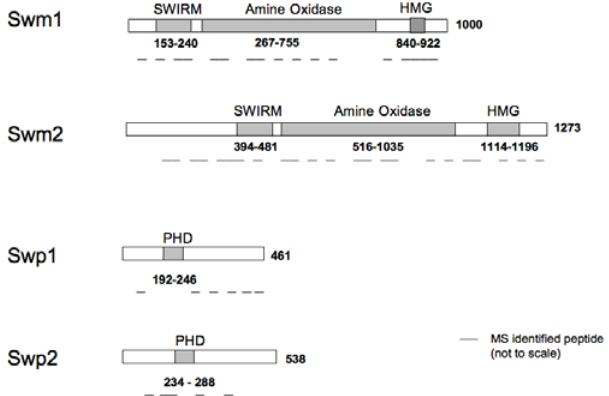
Figure 1. Schematic representation of Swm1/2 complex members: Swm1 (SPBC146.09c), Swm2 (SPAC23E2.02), Swp1 (SPCC4G3.07) and Swp2 (SPAC30D11.08c) are annotated with domain borders as in the SMART sequence analysis database